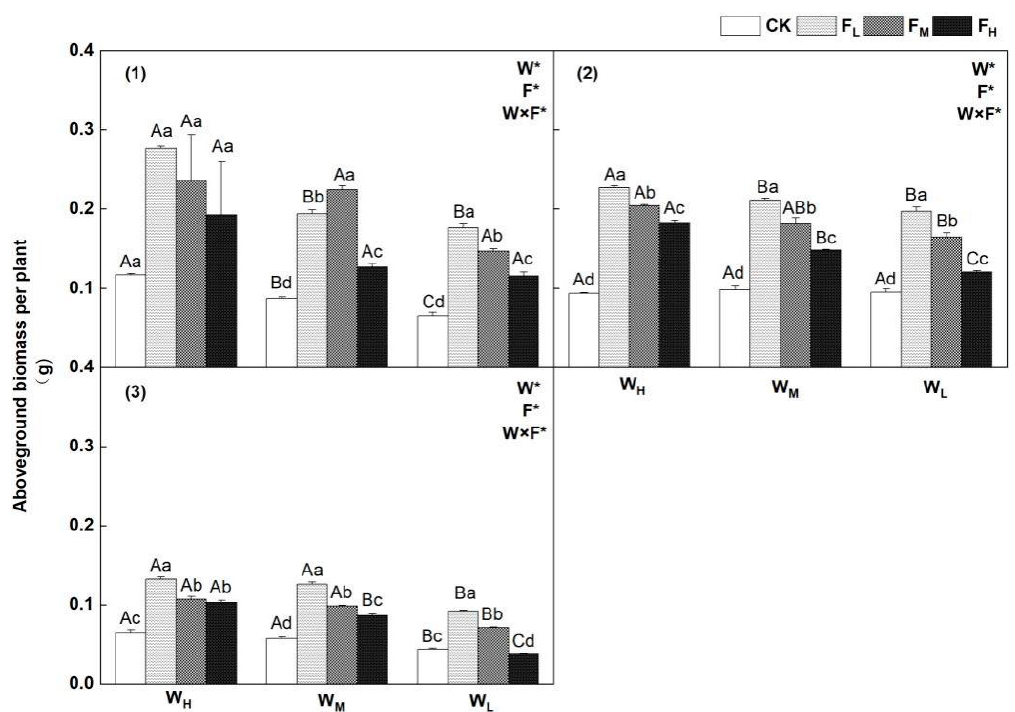
Figure 3. Changes in aboveground biomass values of test plant species under different water–fertilizer treatments. Numbers ( 1 ) − ( 3 ) in brackets indicate P. crymophila , F. coelestis , and S. purpurea, respectively. W, F, and W × F indicate the results of ANOVAs ( p < 0.05) for the effects of water, fertilizer, and their interactions. Asterisk (*) and ns indicate significant difference and non-significant. The uppercase letters and lowercase letters represent the difference between water and fertilizer treatments.